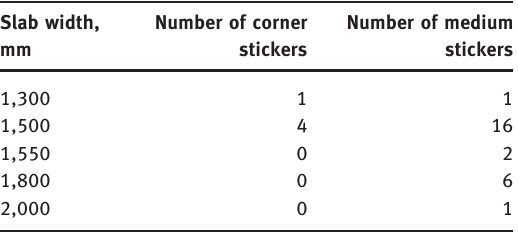
Table 3: Relationship between slab dimension and sticker ’ s